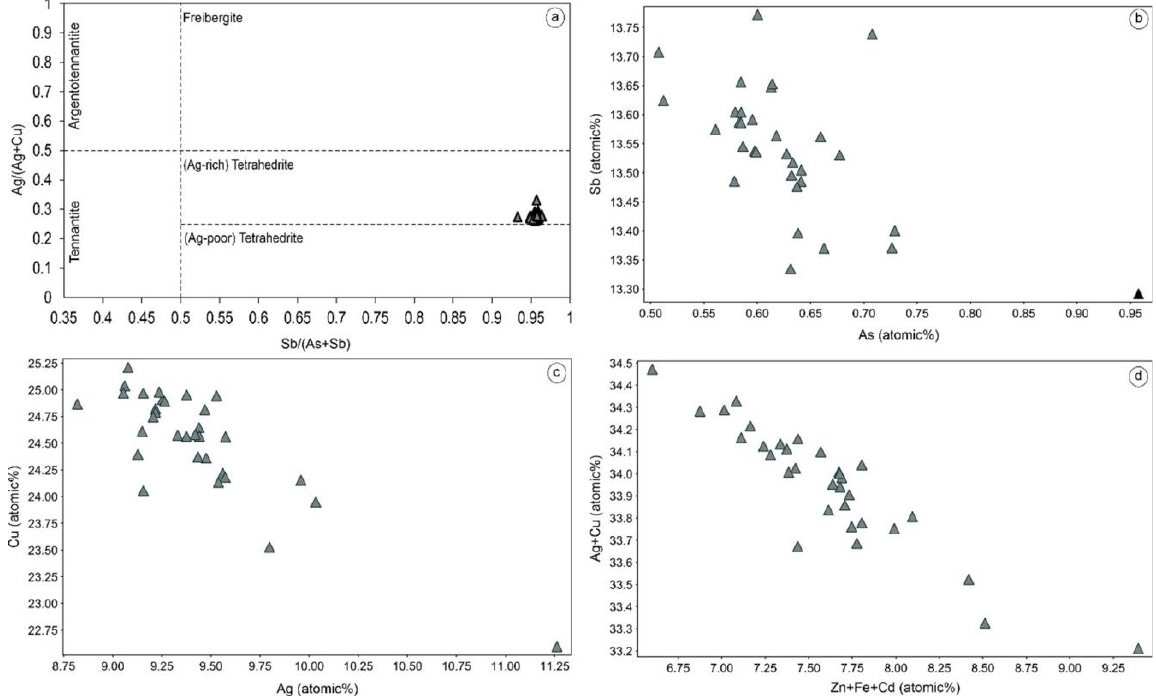
Figure 6. ( a ) Classification of tetrahedrite group minerals where the sample from this deposit is classified as an Ag-rich tetrahedrite (diagram modified after [16]); ( b – d ) negative correlation of some major elements in the tetrahedrite that indicate elemental substitution. major elements in the tetrahedrite that indicate elemental